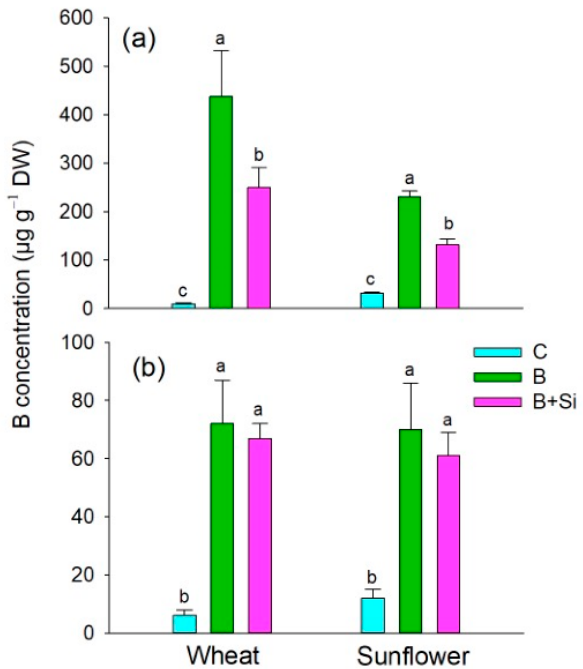
Figure 2. Concentrations of total B in shoot ( a ) and roots ( b ) of sun fl ower and wheat plants. Plants were grown for 14 d in the following treatments: C (control; 1 µM B for wheat and 10 µM B for sunflower), B (500 µ M B), and B + Si (500 µ M B + 1.5 mM Si). Data are means ± SD (n = 4). Statistically significant differences between treatments for each crop ( p < 0.05, Tukey’s test) are indicated by different